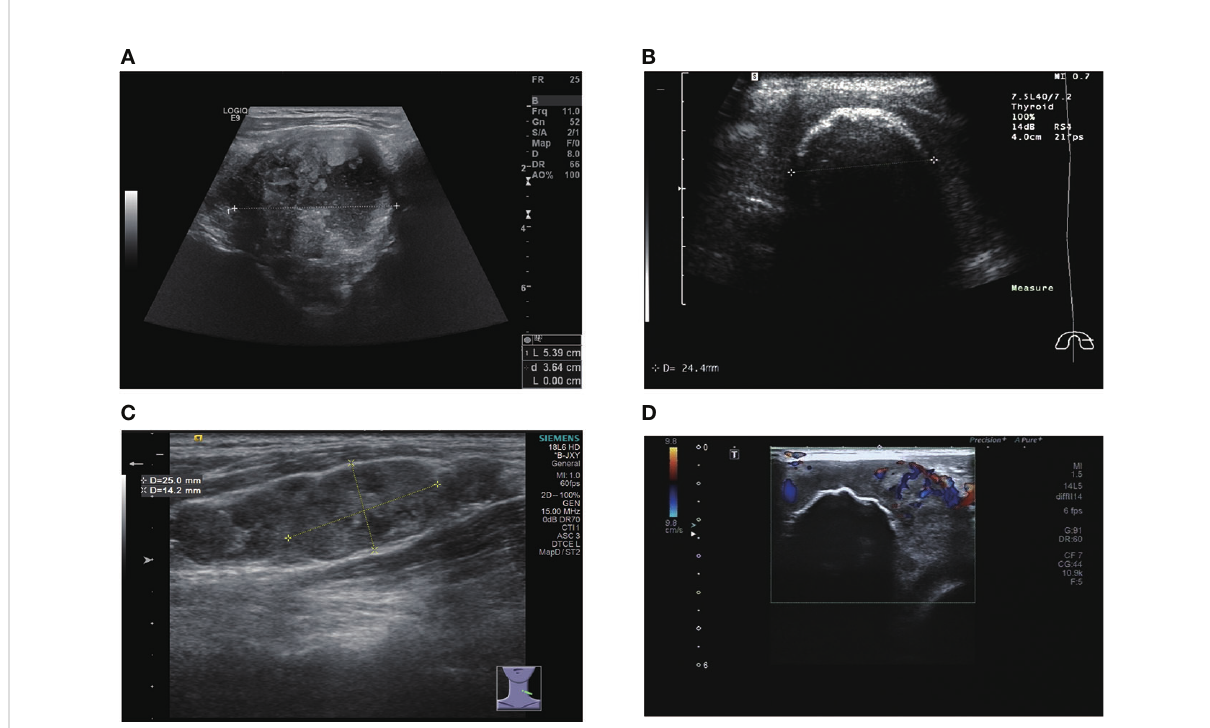
FIGURE 1 (A) large nodule with internal necrosis. (B) there is a large, eggshell-like calci fi cation on the surface of the nodule; information on the interior is not accessible. (C) metastatic lymph nodes appear like beads on the left side of the neck. (D) there is a large calci fi cation inside the nodule and CDFI shows a grade 2 blood fl ow signal.